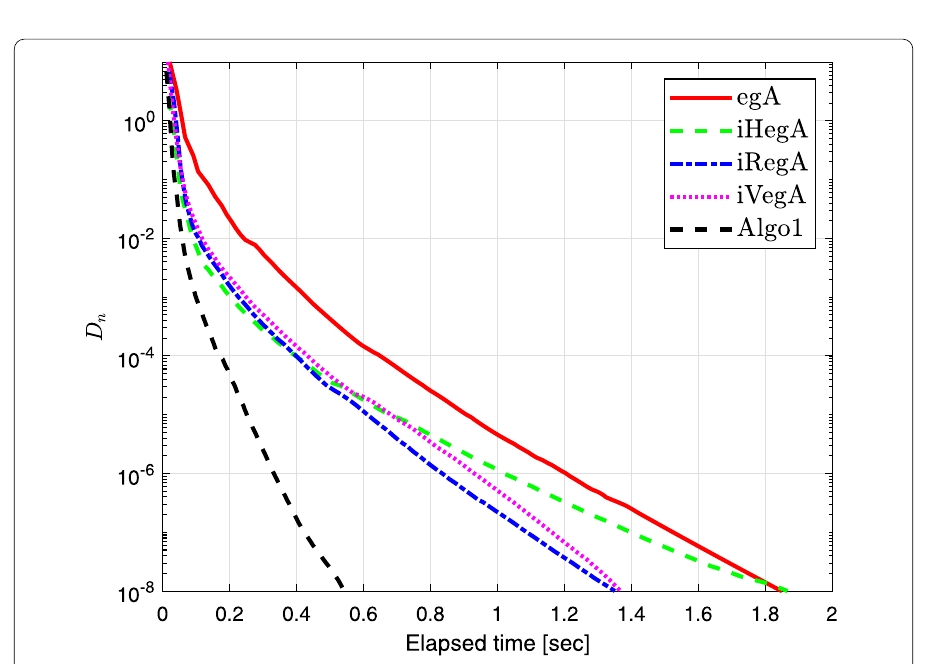
Figure 2 Example 5.1 when n = 50: the number of iterations is 137, 145, 120, 119, 126,